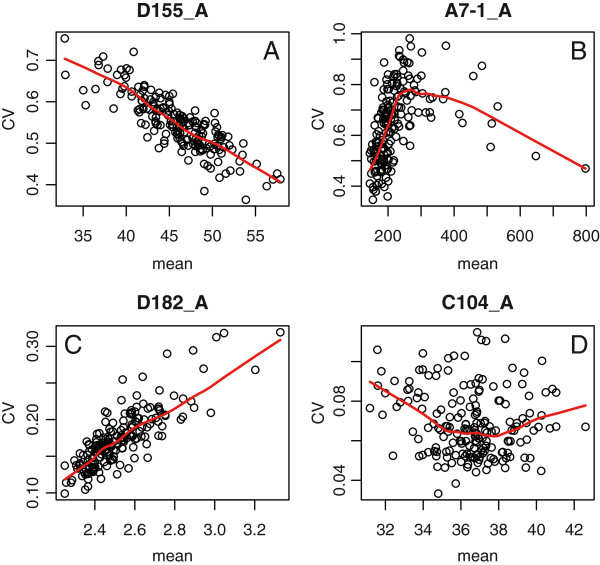
Complex noise-vs-mean dependency of single-cell phenotypes. Each plot represents 185 samples (5 per strain) of at least 200 cells each. x-axis: ‘mean’ value of the trait of interest in the sample. y-axis: coefficient of variation of the trait values within the sample. Four traits (indicated in headers) are shown as examples to indicate that the noise vs. mean dependency can be linear (A and C) or not (B and D), and negative (A) or positive (C). Red line: Lowess regression model used to condition noise on mean values. D155_A: Angle between [from cell center to brightest point in nucleus] and [end of major axis of the cell] at G1. A7-1_A: Size of actin region at G1. D182_A: Nuclear axis ratio at G1. C104_A: Short axis length in whole cell at G1.